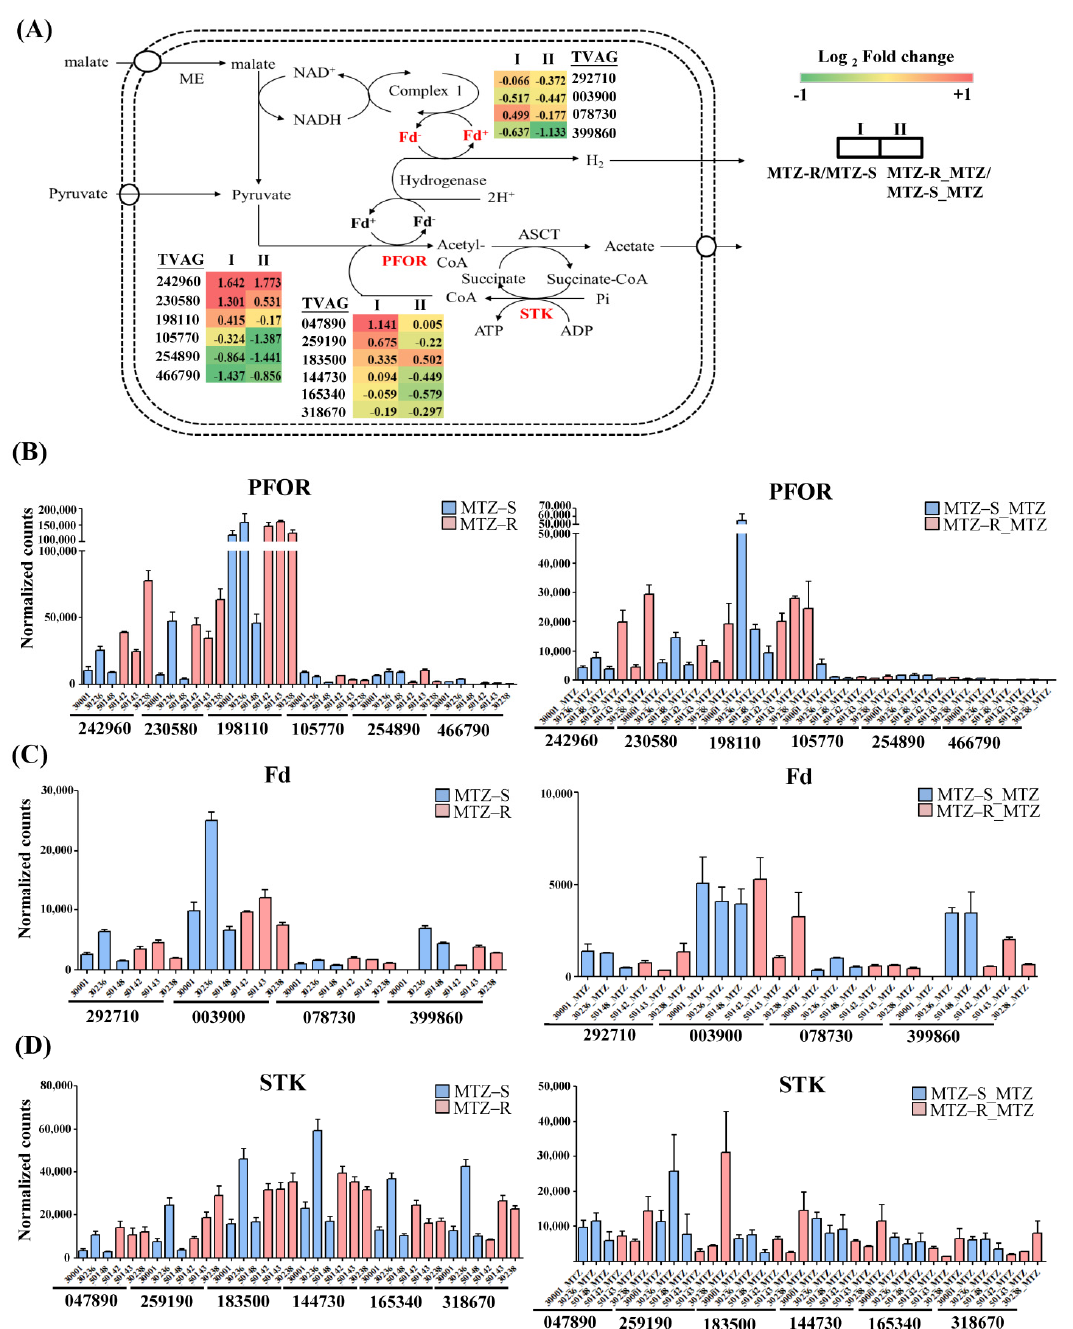
Figure 3. Differential expression of the hydrogenosomal genes in the MTZ-R T. vaginalis transcriptomes treated with or without MTZ. ( A ) Differential gene expression of PFOR, Fd, and STK at the isoform levels between the MTZ-R and MTZ-S transcriptomes treated with (MTZ-R_MTZ/MTZ-S_MTZ; II) or without MTZ (MTZ-R/MTZ-S; I) were presented as log2 fold change. Genes shown in red and green color indicate upregulation and downregulation, respectively. Gene expression levels of different ( B ) PFOR, ( C ) Fd, and ( D ) STK isoforms in the MTZ-R and MTZ-S transcriptomes treated with or without MTZ were presented as mean ± SD of normalized counts values obtained from three independent RNA-seq experiments.